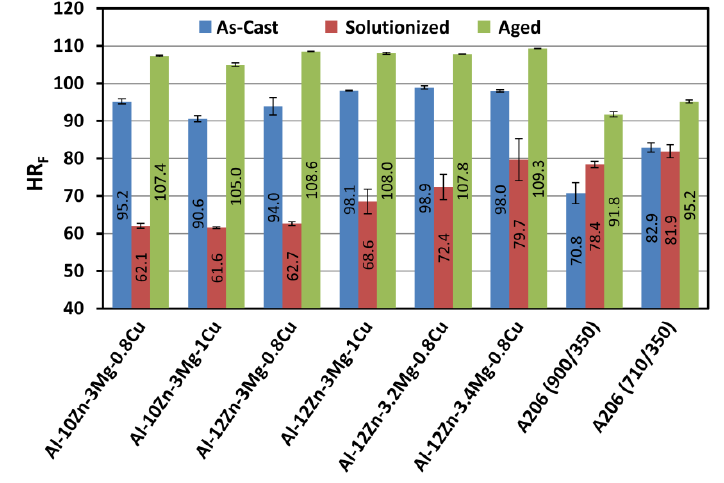
Figure 4. Comparison of the Rockwell F Hardness ( HR Solutionized, and Aged Conditions (Note: Data for Al-Zn-Mg-Cu Aged corresponds to 10 h aging treatment. Data for A206 Aged is for the T7 condition and numbers in parentheses denote pouring temperature and mold temperatures in degrees Celsius,